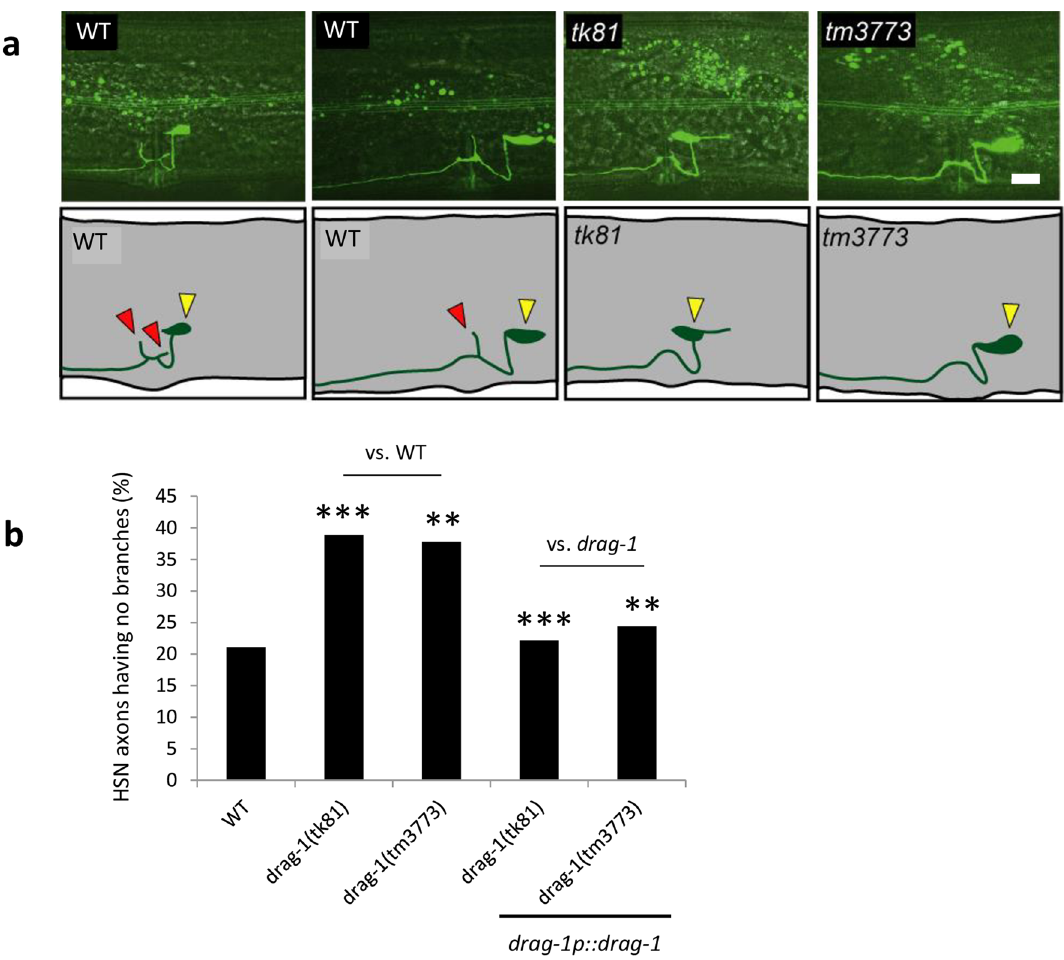
Figure 2. HSN branching phenotypes. ( a ) HSN axon branching. Upper panels: Confocal micrographs of HSNs in wild-type and drag-1 mutant young-adult hermaphrodites with the unc-86p::myrGFP transgene. Lower panels: Schematic representations of HSN morphology. Yellow and red arrowheads depict the HSN cell body and axonal branches, respectively. Anterior is to the left, dorsal top. Scale bar: 10 μm. ( b ) Quantification of the HSN branching phenotypes in various strains. Percentages of HSNs having no branches are shown. Branching phenotypes were scored using fluorescence microscopy. drag-1(tk81) and drag-1(tm3773) mutants were compared with those transgenic for drag-1p::drag-1 . Significant differences were determined by Fisher’s exact test. ***P < 0.001, **P < 0.01. n = 180 for each drag-1 acts in parallel pathways with sma-1 and sma-5 .